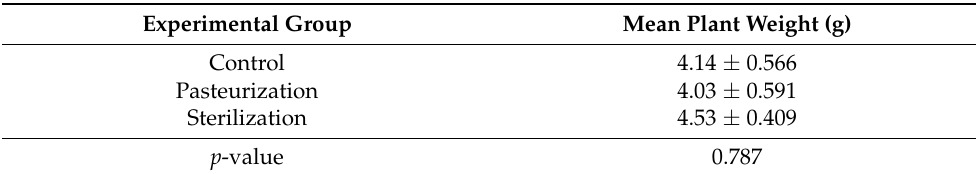
Table 10. Effects of compost treatments on the fresh weight of tomato seedlings 26 days following seeding ( n = 4). Values are given as the mean ± standard